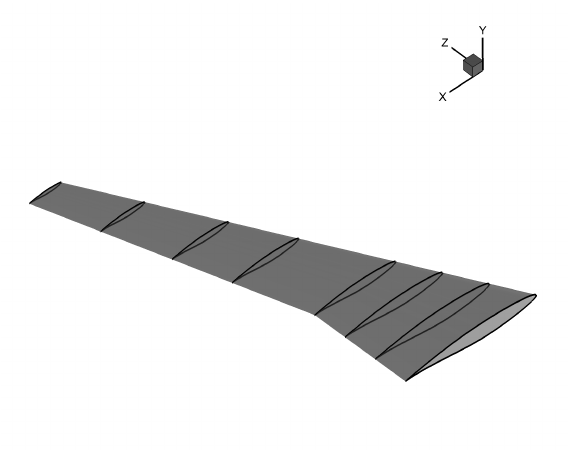
Figure 7. Distribution of the wing sections.